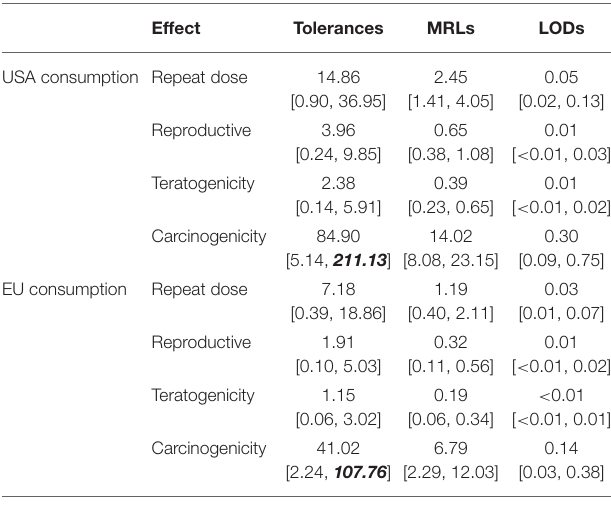
TABLE 5 | Human food safety of consuming poultry tissues with fenbendazole sulfone residues applying a Ufs of